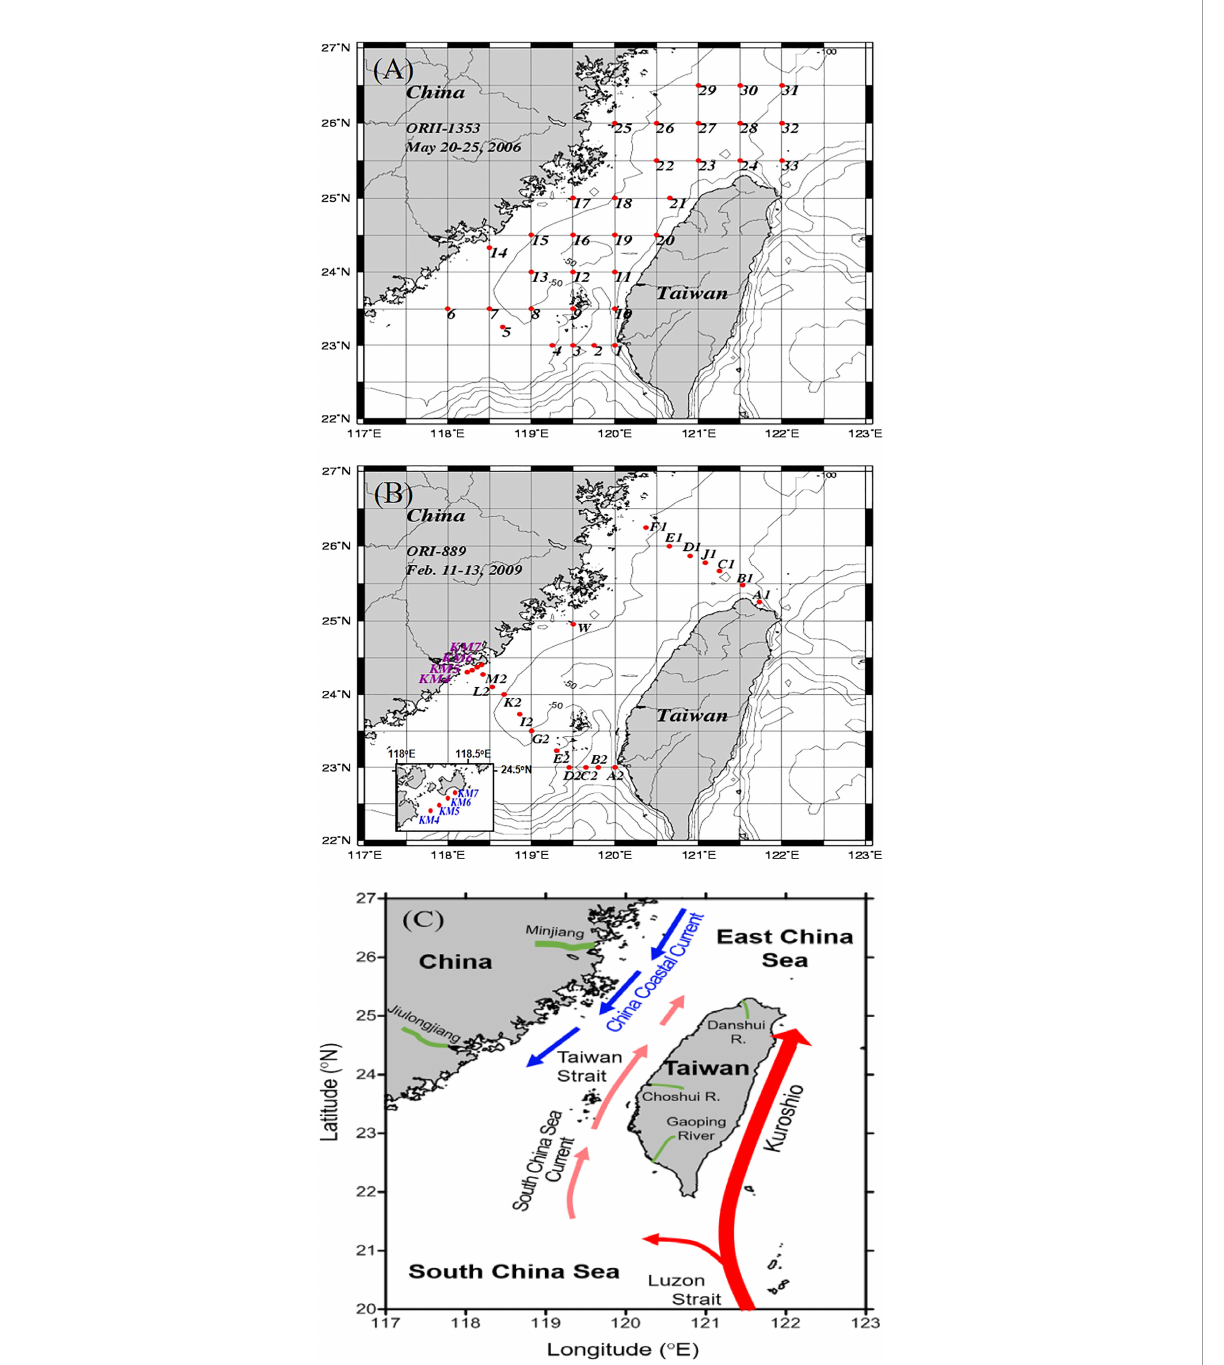
FIGURE 1 Study area and sampling locations in the Taiwan Strait in early summer ( A , Stations 1 − 33, ORII CR1353) and winter ( B , ORI CR889). Arrows represent the regional circulation patterns associated with the Taiwan Strait (C) . Different sizes of red and light red arrows represent the difference in warm, saline, and current strength for Kuroshio Current and South China Sea Current, respectively. The blue arrow indicates cold and less saline China Coastal Current during winter. The discharge of river water is shown by the different width of short green line in southeast China and Taiwan. The Kuroshio intrusion into the South China Sea (SCS) tends to be stronger in winter than in summer (Wu et al., 2017), and the China Coastal Current and SCS Current prevail in winter and in summer, respectively (Jan et al., 2002; Hu et al.,